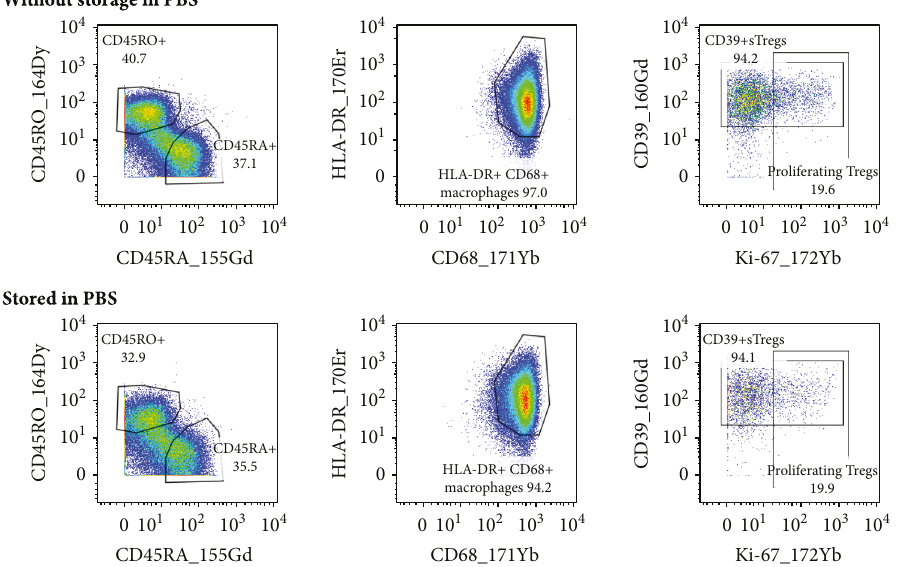
Figure 4: Sample storage in PBS with 1% BSA. Tumor cells and PBMCs were isolated from a patient with HNSCC and stained for viability. After CD45-based barcoding, samples were halved. One part of the cells was stained with the panel of antibodies immediately, and the other part was stored in PBS with 1% BSA at 4 ° C overnight and labeled the next day. Dot plots display some representative markers of the blood sample. Gates were adjusted for cell samples stained immediately after